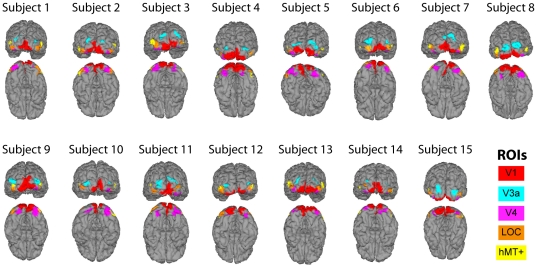
ROI locations for all subjects color coded and shown from posterior and inferior perspectives.